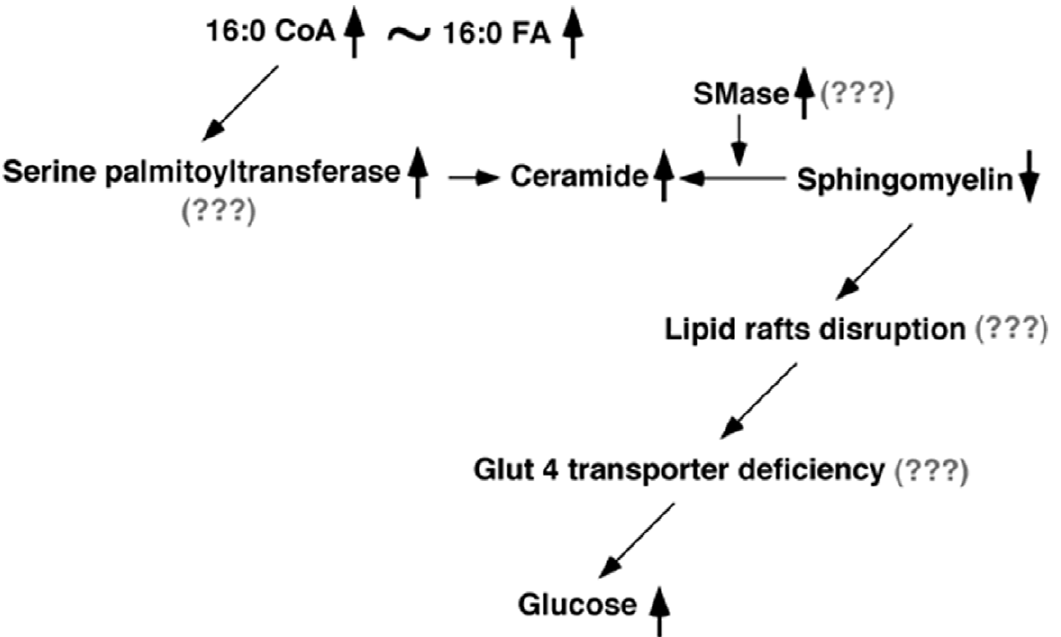
Figure 10. A proposed working model of the altered sphingolipid metabolism in Alzheimer’s disease. See text for details.